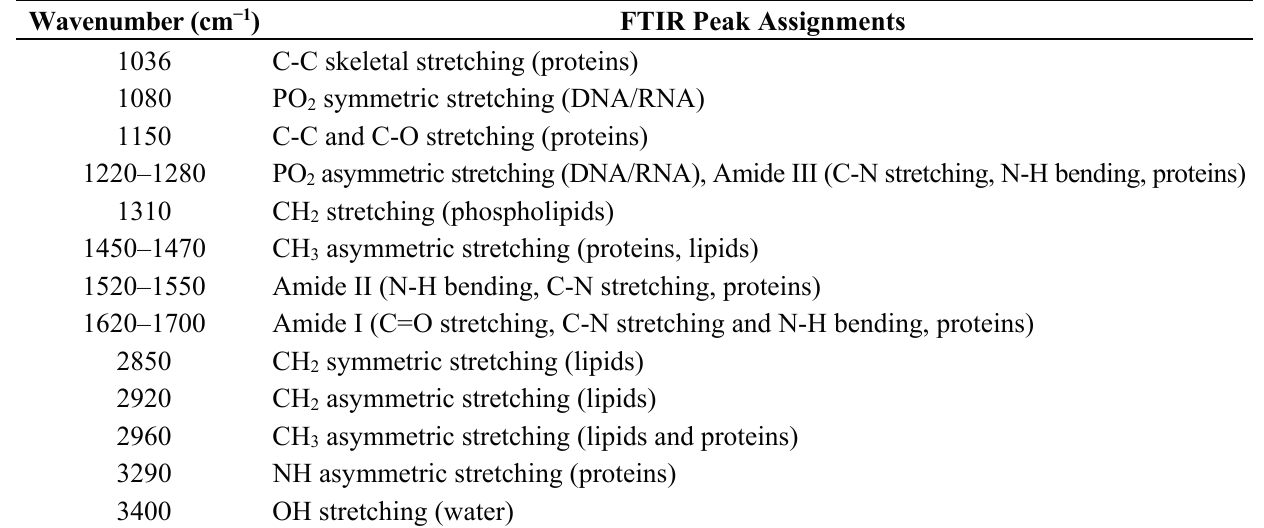
Figure 2. Typical FTIR spectrum from a population of cells. Table 1. Tentative peak assignments [3] for typical FTIR cellular spectrum shown in Figure